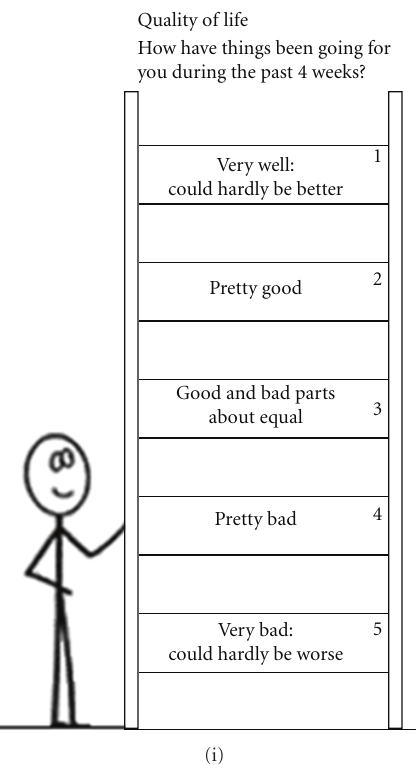
Figure 2: Example of COOP/WONCA